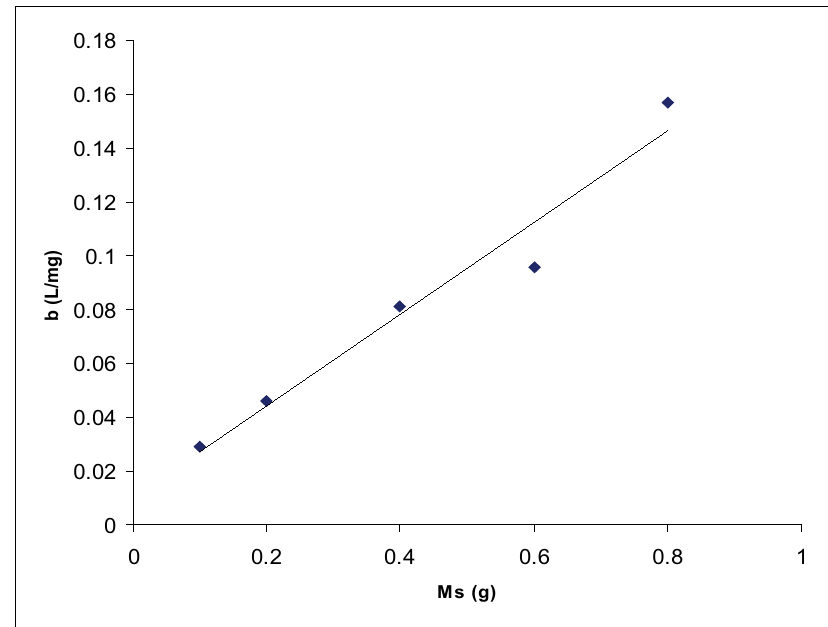
Figure 3. Linear plot of the value of b (L mg -1 ) against m